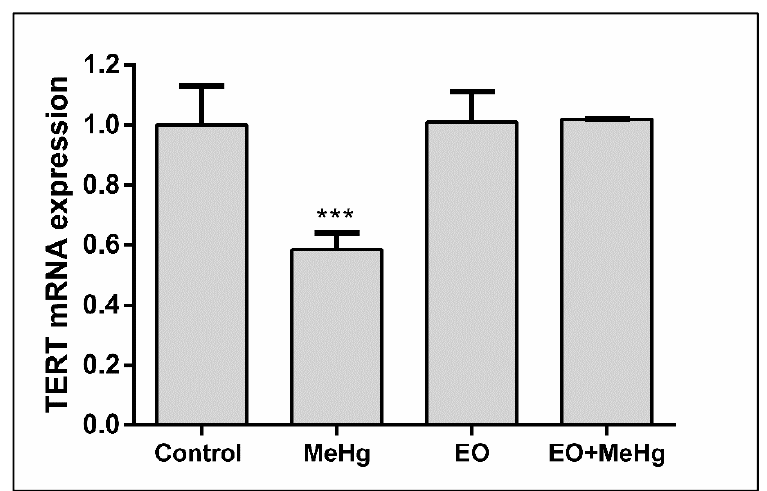
Figure 7. Euterpe oleracea juice for human consumption prevents reduced levels of telomerase reverse transcriptase (TERT) mRNA expression caused by methylmercury exposure. Mice were treated with clarified E. oleracea juice (EO) once a day for 8 days and/or methylmercury (MeHg) for 4 days. Fold change data are presented as mean ± SEM ( n = 6–8). *** P < 0.001 vs all groups.